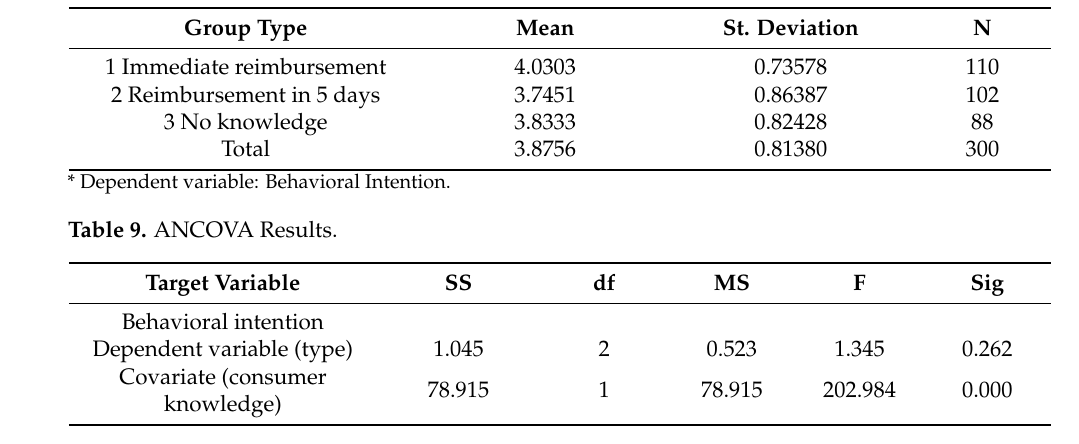
Table 8. Descriptive statistics.